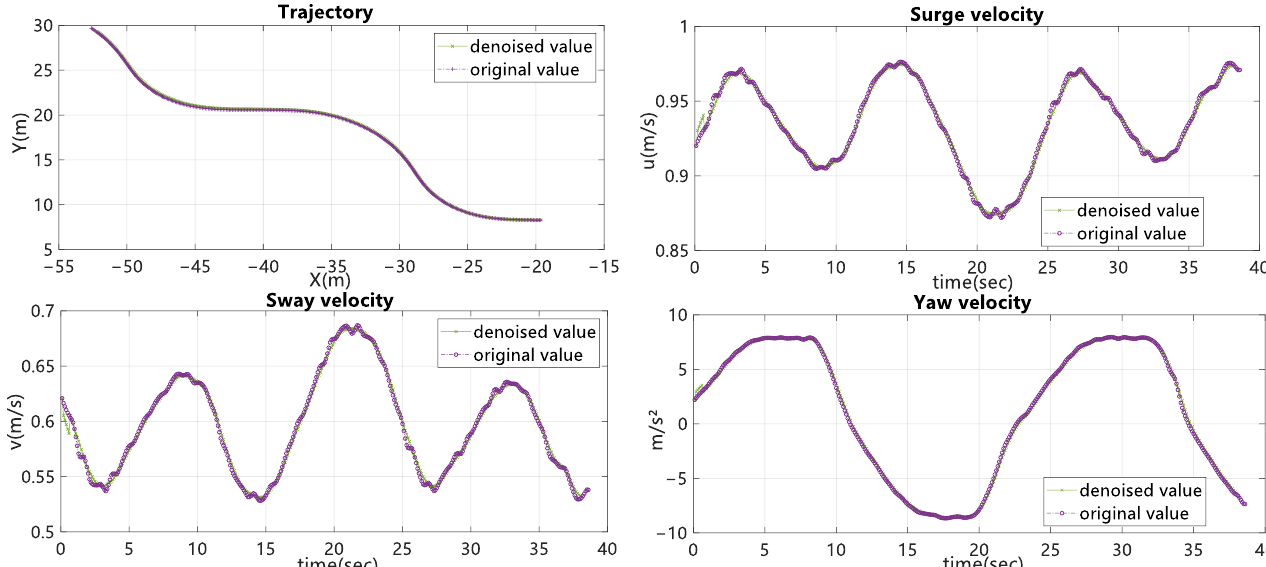
Figure 7. Identification results based on the denoised data.